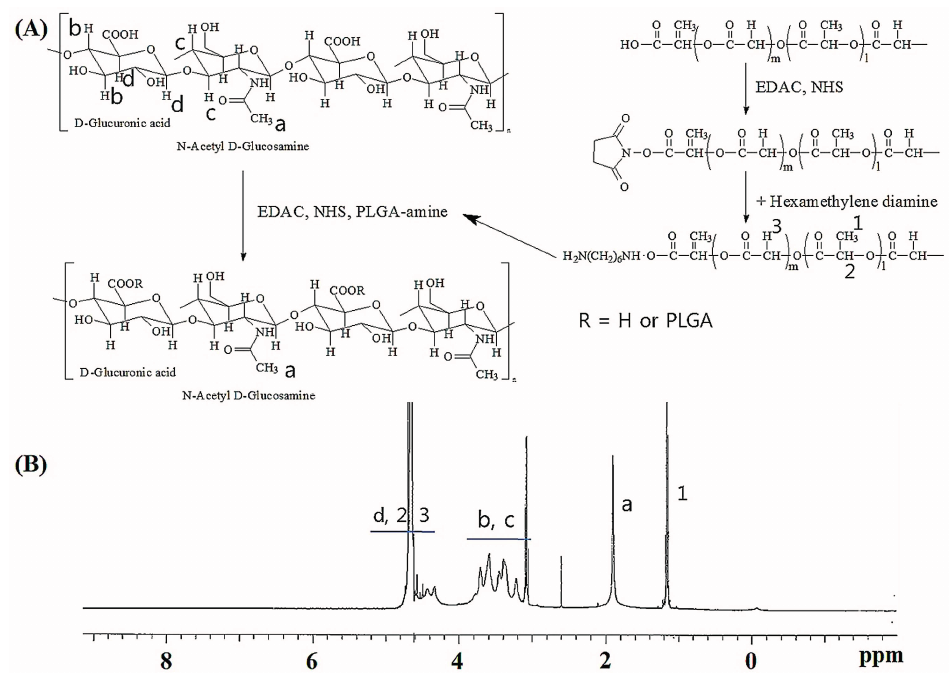
Figure 1. ( A ) Synthesis scheme and ( B ) 1 H NMR spectra of Hyaluronic Acid (HA) and Poly( D , L -lactide-co-glycolide) (PLGA) copolymer (HAgLG).